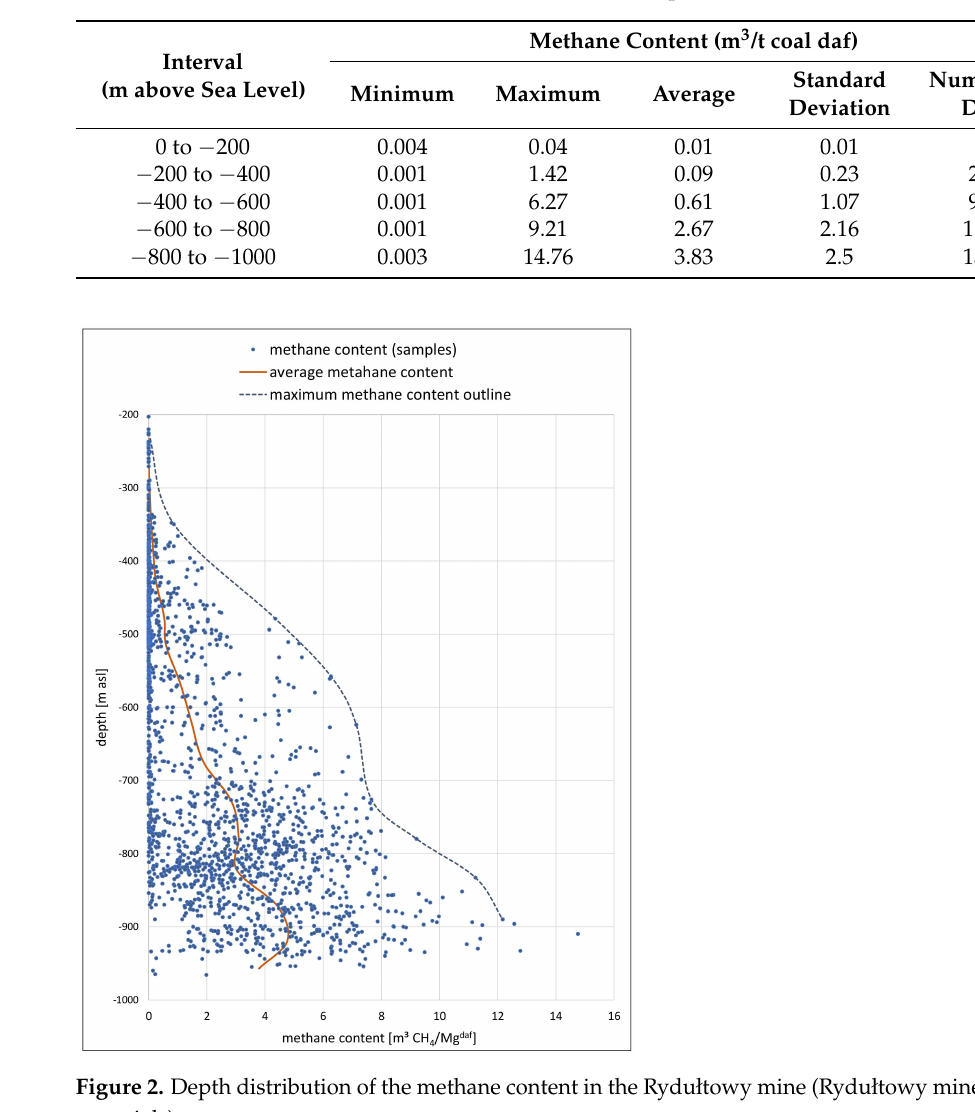
Table 2. Parameters of the methane content at individual depth intervals.